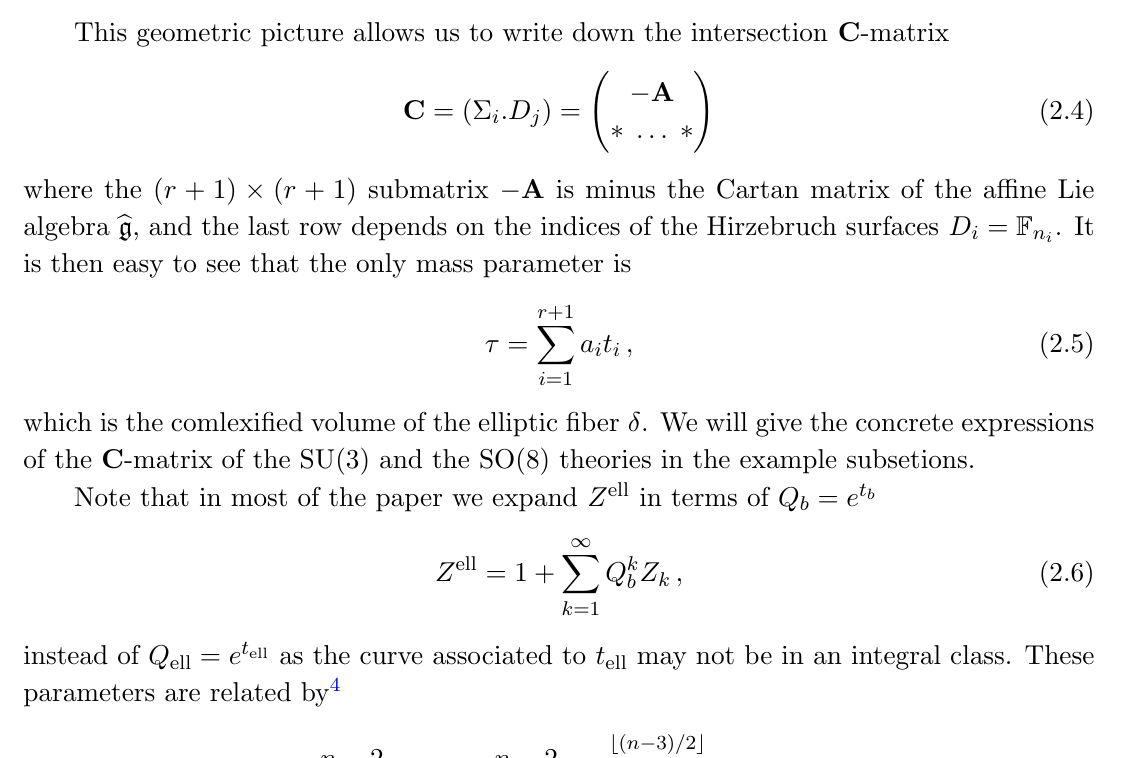
corresponds to the a(cid:14)ne +1